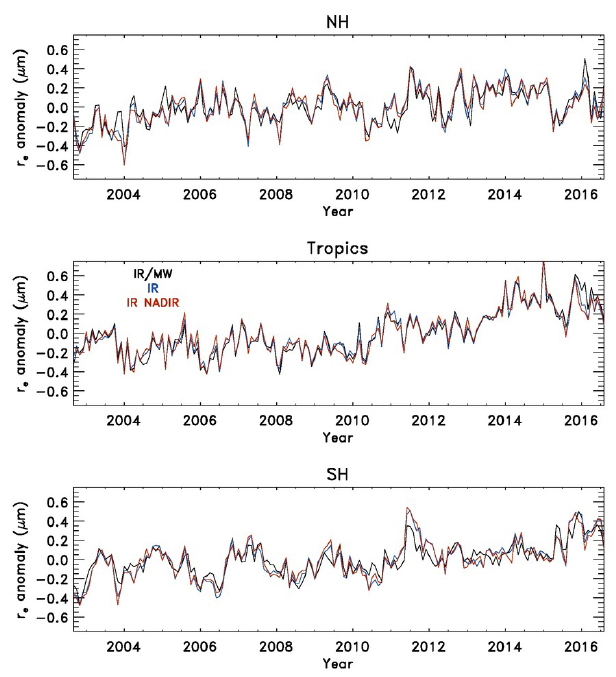
Figure 5. Monthly anomaly time series for r ei for the IR/MW, IR only, and IR nadir retrievals organised into three latitude bands: SH extratropics (54–18 ◦ S), tropics 18 ◦ S–18 ◦ N, and NH extratropics (18–54 ◦